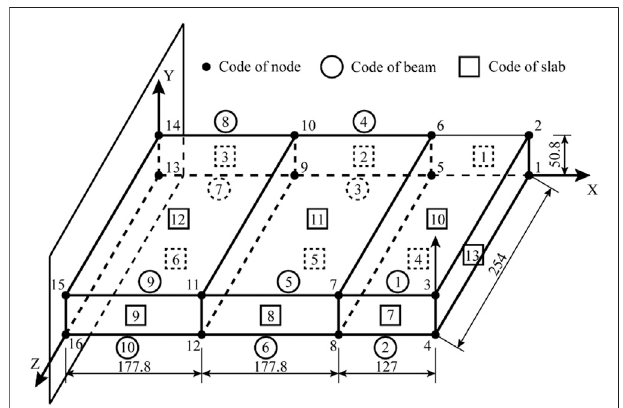
FIGURE 3 | Wing box structure